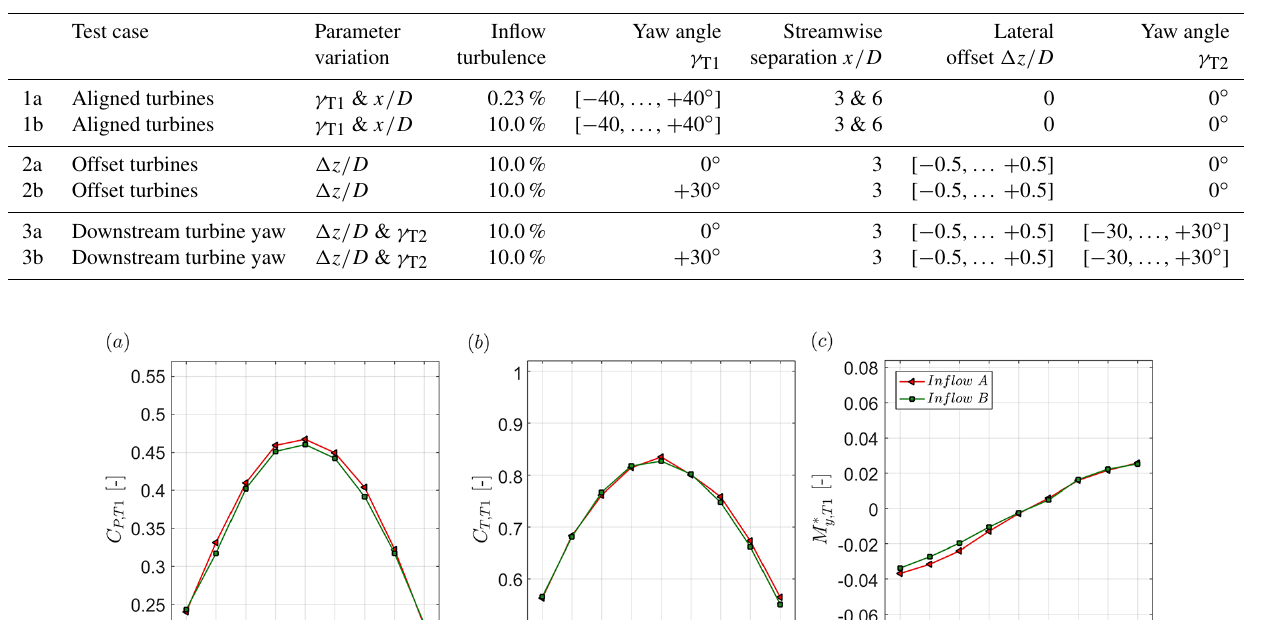
Table 1. Overview of test cases.